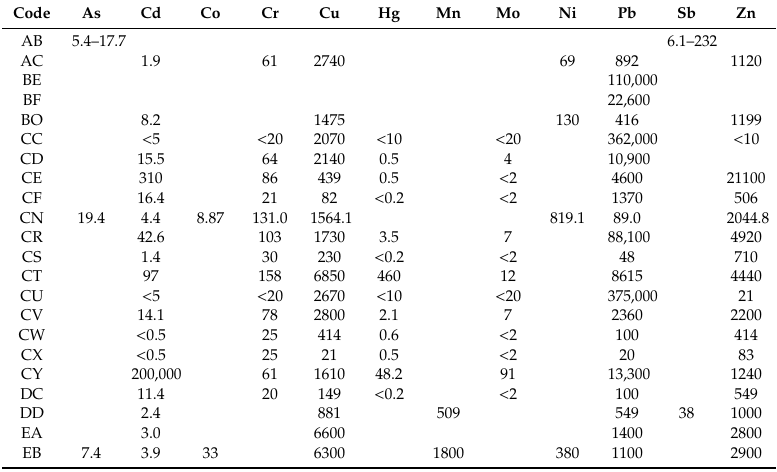
Table 3. Concentration of heavy metals and metalloids in dust samples (values expressed in mg /